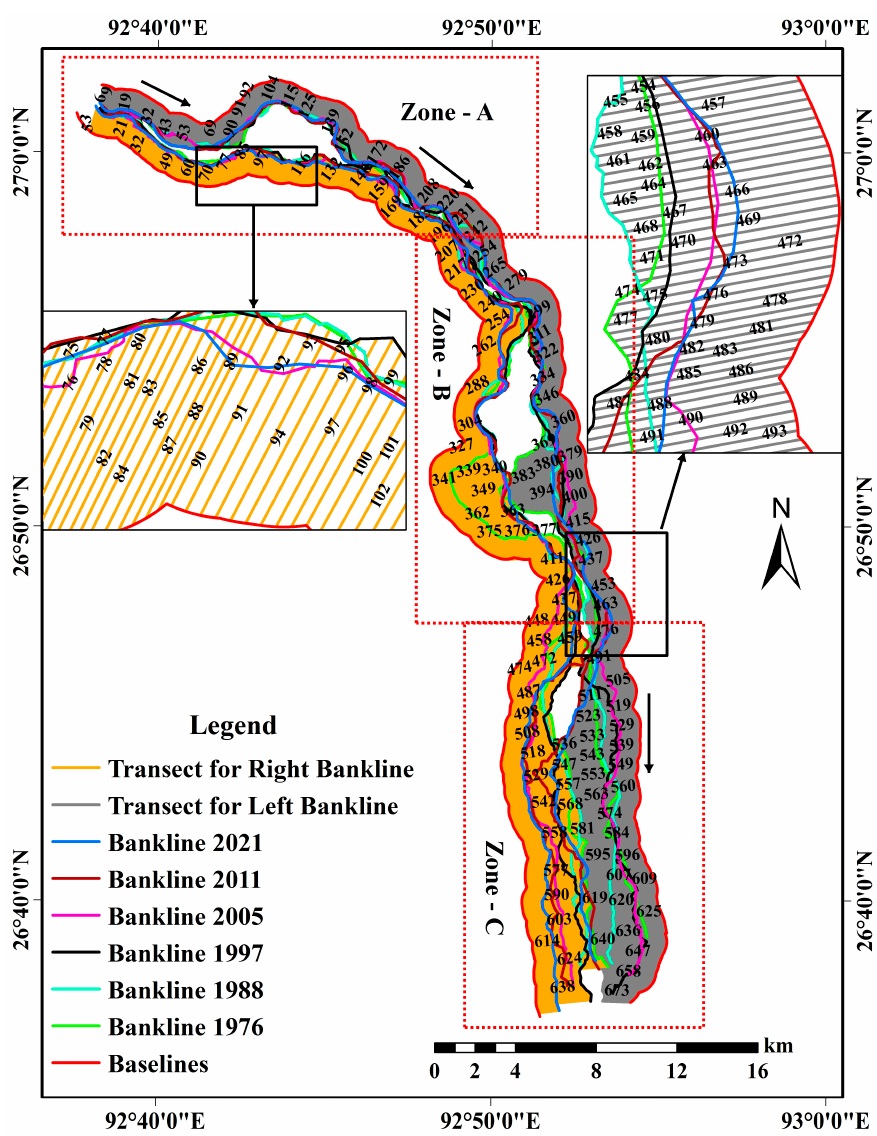
Figure 3. Banklines of selected study years are positioned along the baseline and transect lines were drawn separately for both the right and left bank. All transects are oriented at angle with the corresponding baselines. Table 2. Erosion and Deposition Grade according to the range of the EPR/LRR rate.